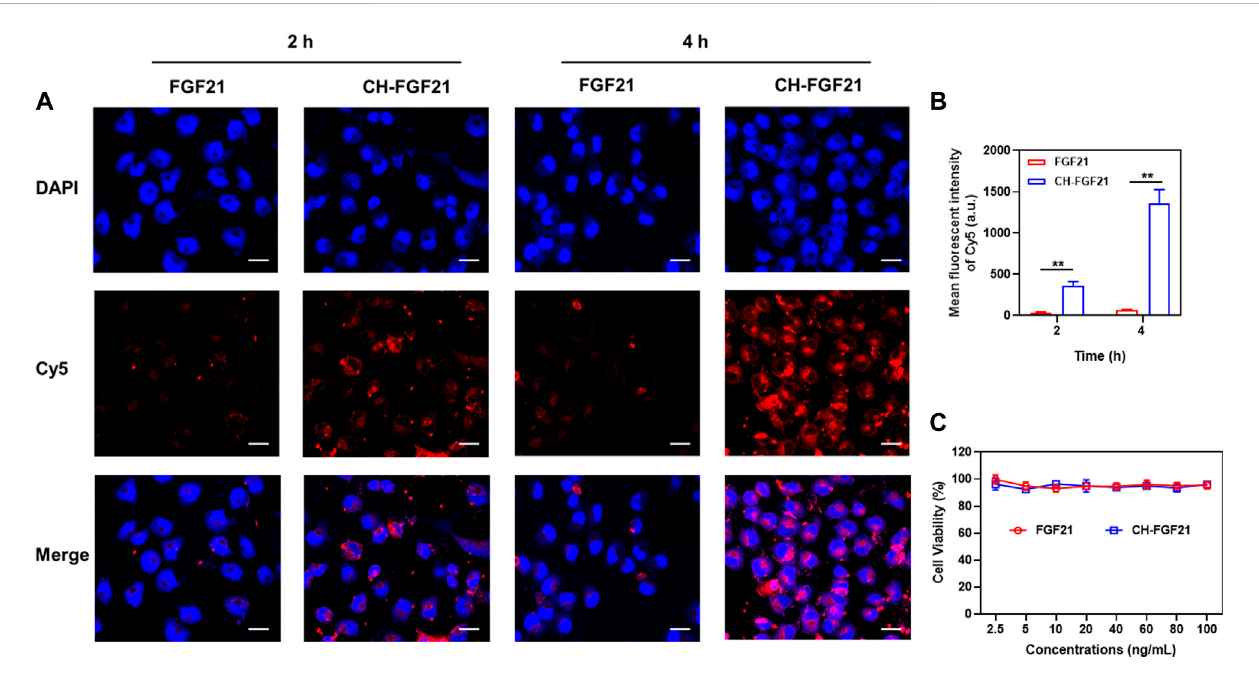
FIGURE 2 Cellular uptake and cytocompatibility of CH-FGF21. (A) Confocal fl uorescence images of AML12 cells incubated with FGF21 (100 ng/mL) or CH-FGF21 (100 ng/mL) after 2 h and 4 h. Scale bar = 20 μ m. (B) Mean fl uorescence intensity of each group. Viability of AML12 cells after incubation with different concentrations of (C) FGF21 or CH-FGF21 for 24 h. Data are the mean ± SD ( n = 3). * p ≤ .05, ** p ≤